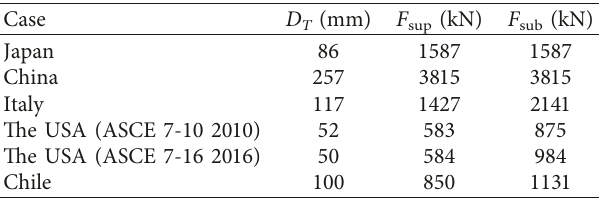
Table 21: Design parameters for static analysis of the analyzed buildings under uniform